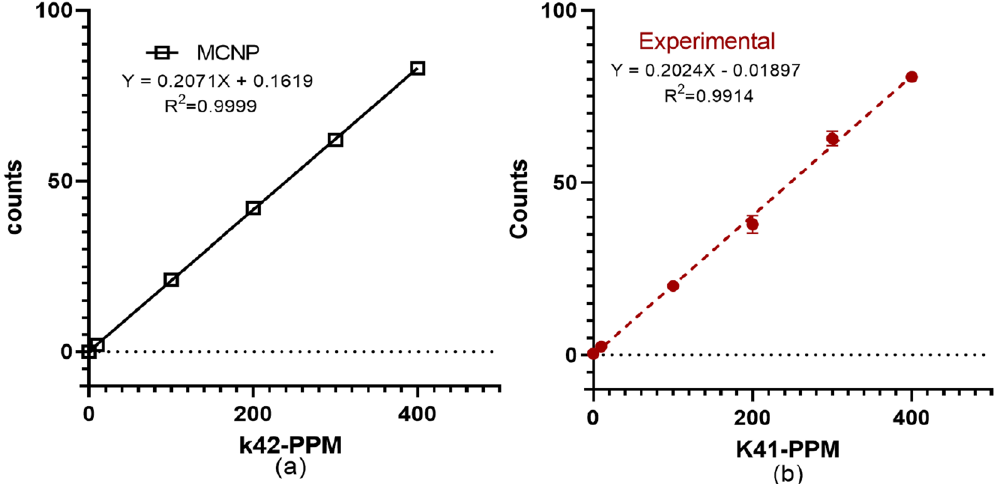
Figure 5. Calibration line for the potassium aliquots of 0 ppm, 10 ppm, 100 ppm, 200 ppm, 300 ppm, 400 ppm (a) MCNP simulation by using the modeled irradiation assembly (b) phantoms measured with experimental setup.